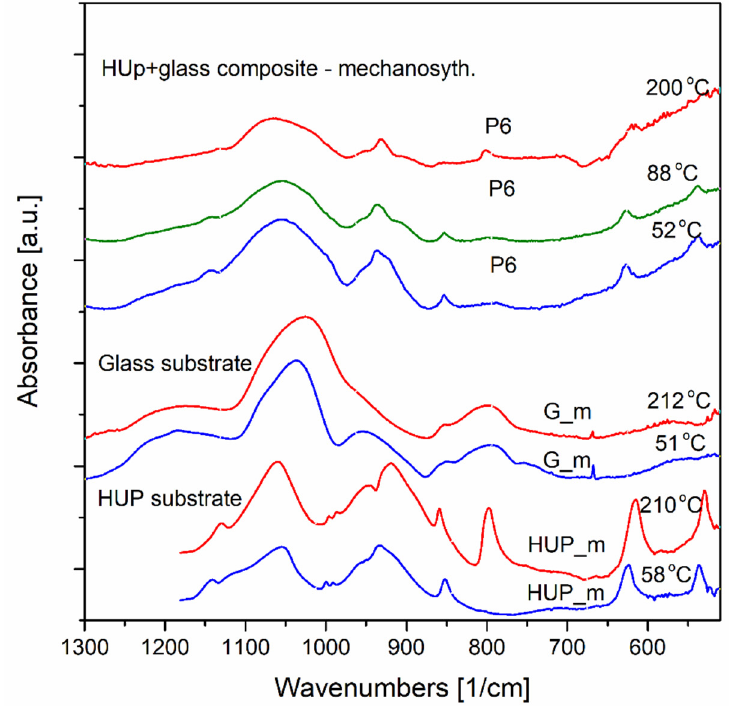
Figure 9. FTIR-ATR spectra of P6 composite samples (40% Gm + 60% HUP) and their substrates (HUP) (UO 2 )(HPO 4 )(H 2 O) 4 and Gm-milled 30P 2 O 5 –70SiO 2 glass. Spectra acquired at elevated temperatures. The spectra were normed and shifted for clarity.